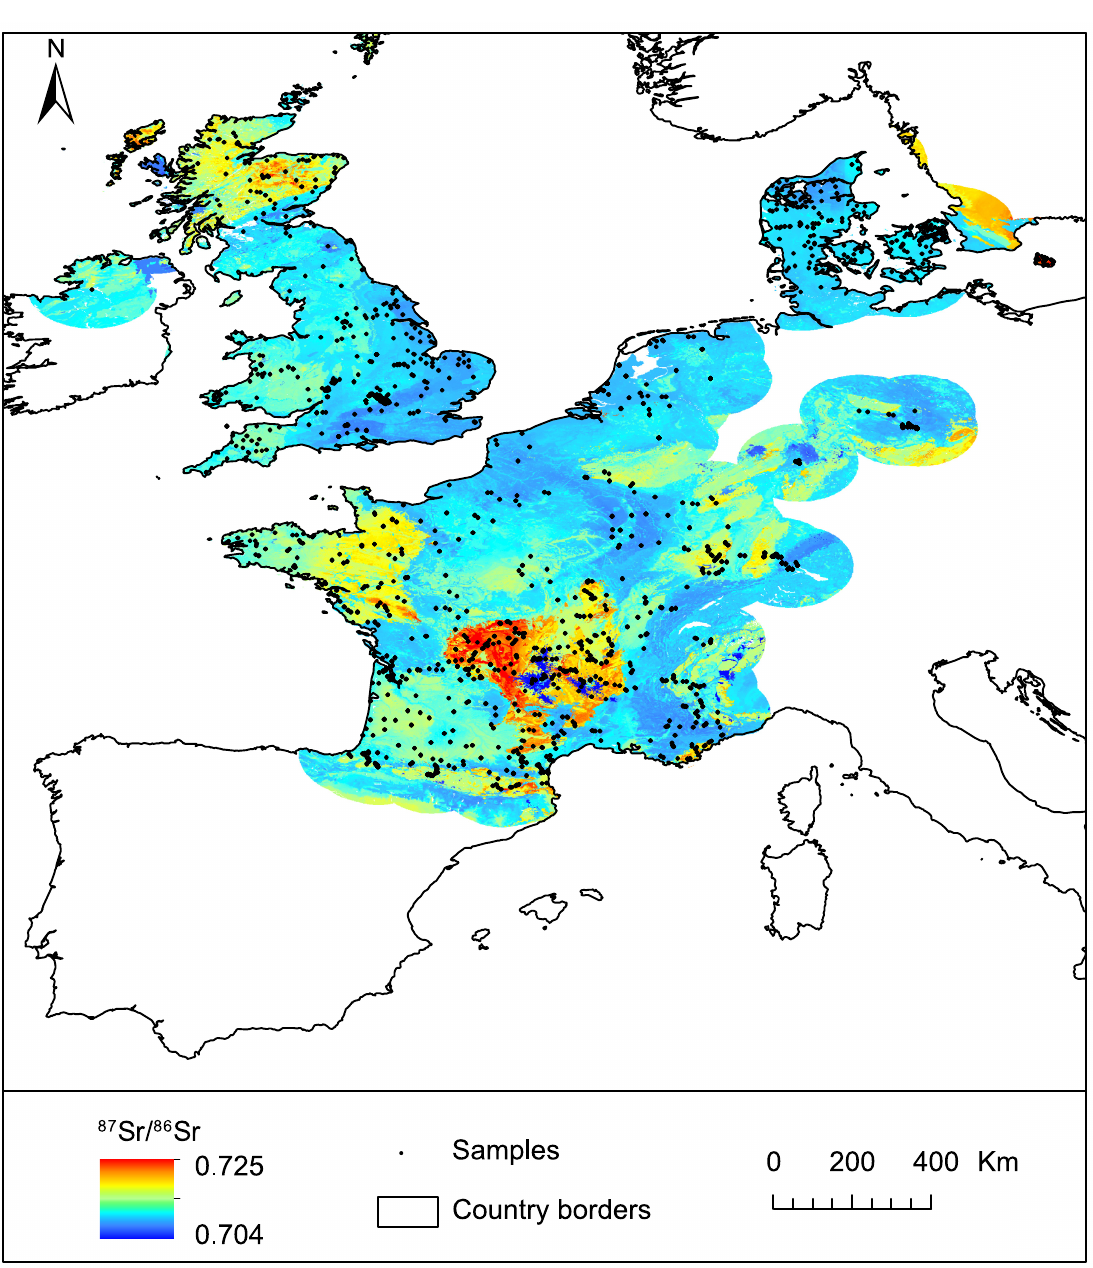
Fig 9. Random forest regression bioavailable 87 Sr/ 86 Sr map for Western Europe. Coastline features are from http://www. naturalearthdata.com/.